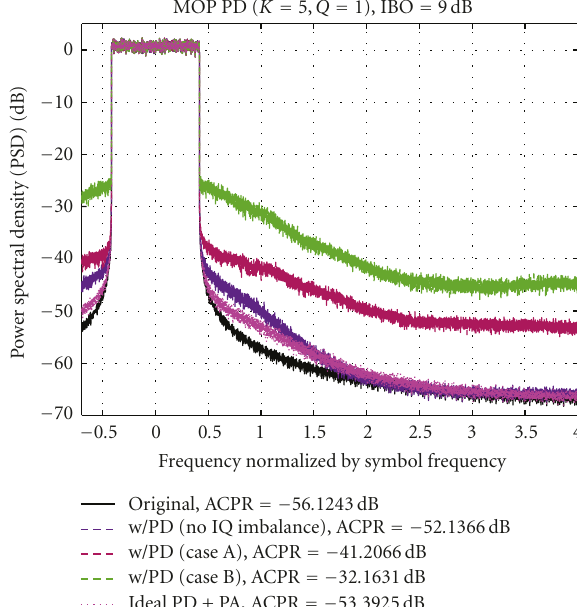
Figure 6: 16-QAM-OFDM constellation and the corresponding EVM value of simulated output of the linearized PA with and without IQ imbalance.